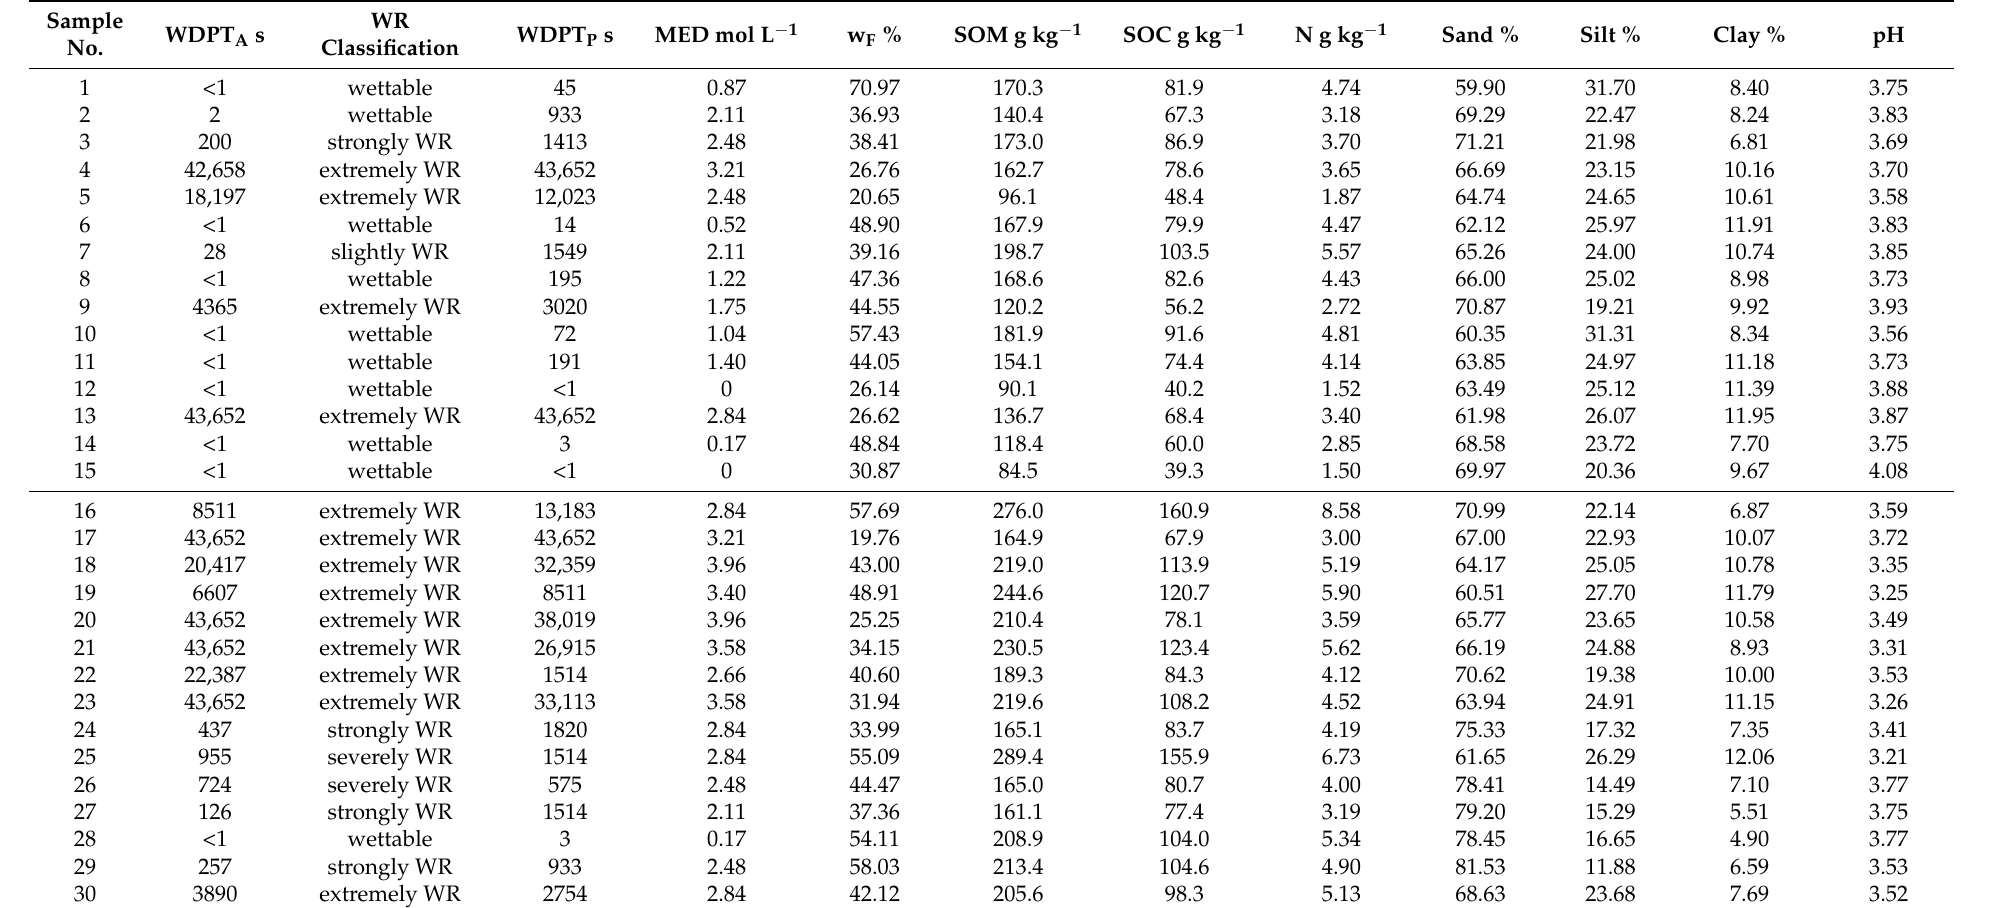
Table 2. Basic soil properties and SWR data for 45 samples (T1 site: samples 1–15, T2 site: samples 16–30, T3 site: samples